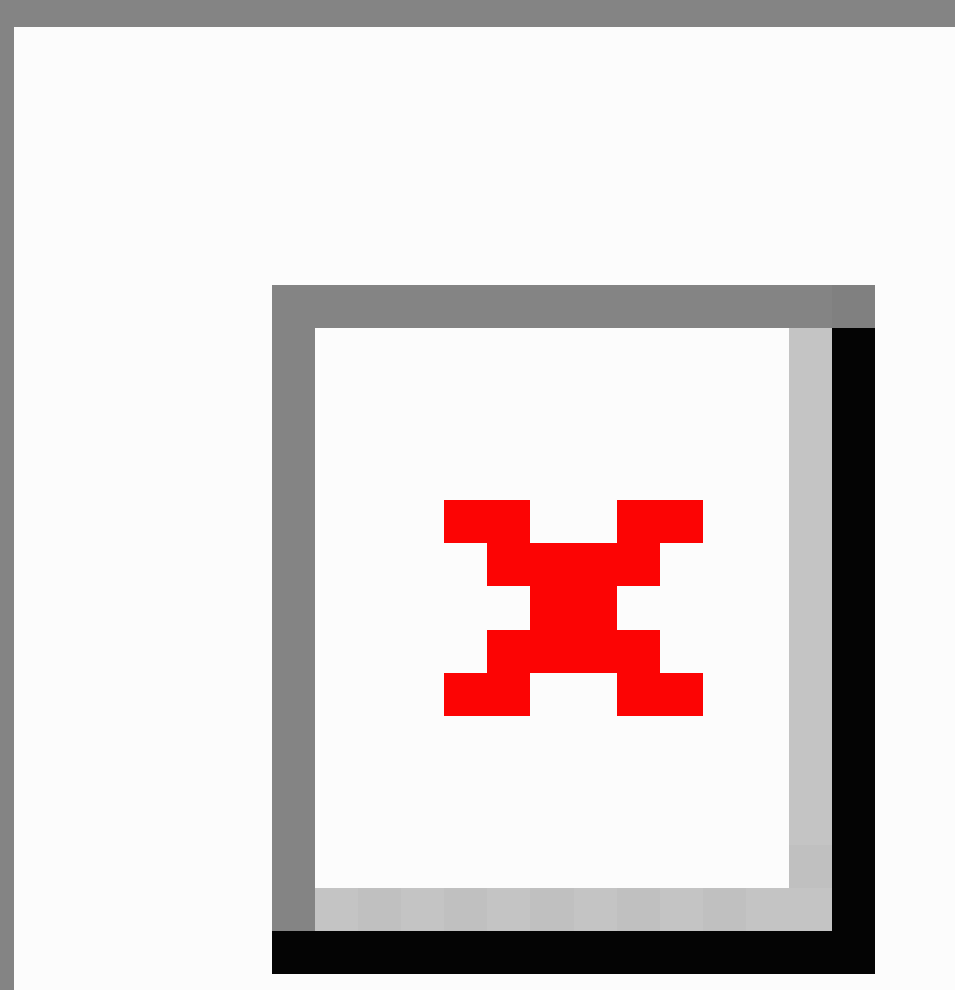
Figure 3. Mixed-methods approach for capturing different dimensions in patient-reported